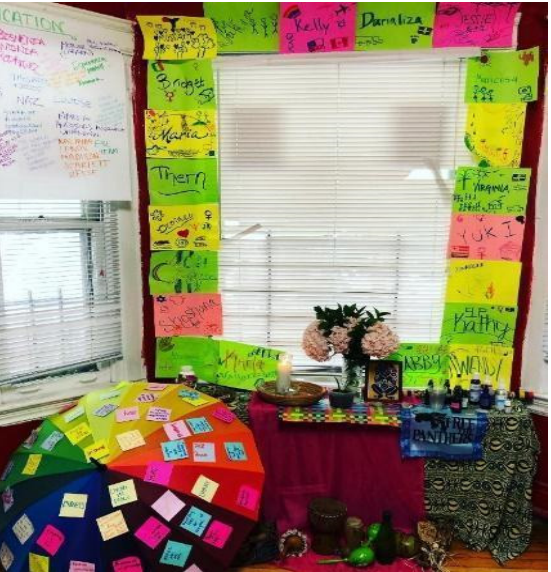
Figure 4. Education for Liberation: Power and Oppression Workshop at FIERCE in the Bronx. 18 May